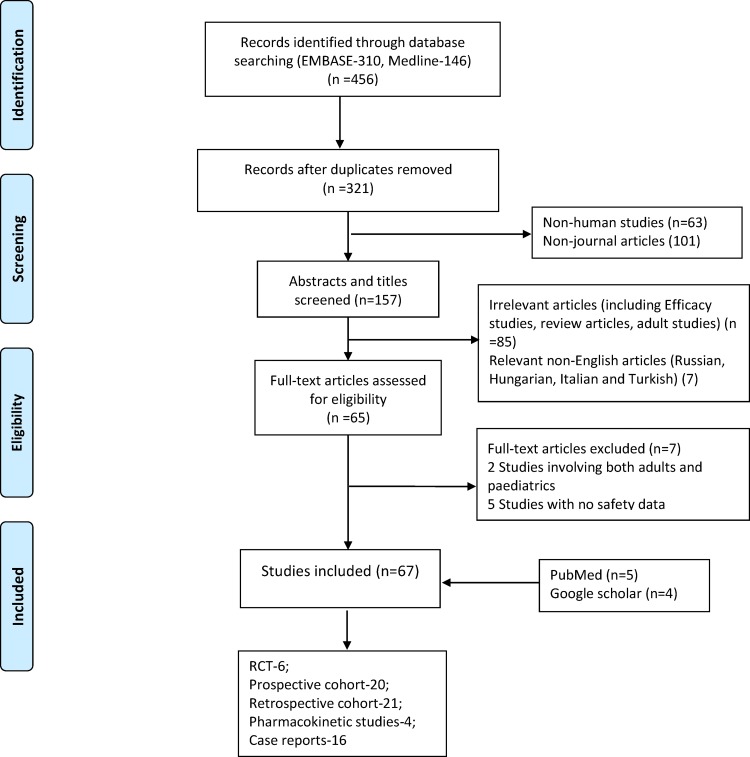
Flow chart of included studies.